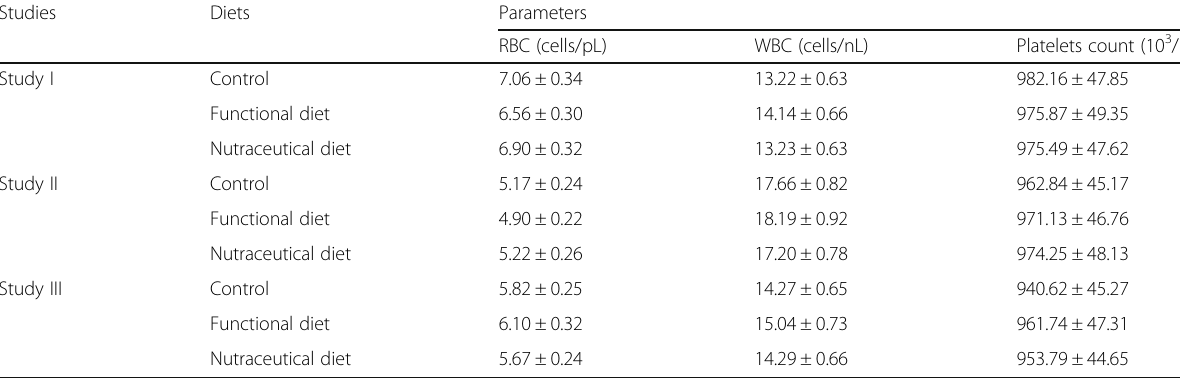
Table 4 Effect of diets on hematological parameters of rats in different studies